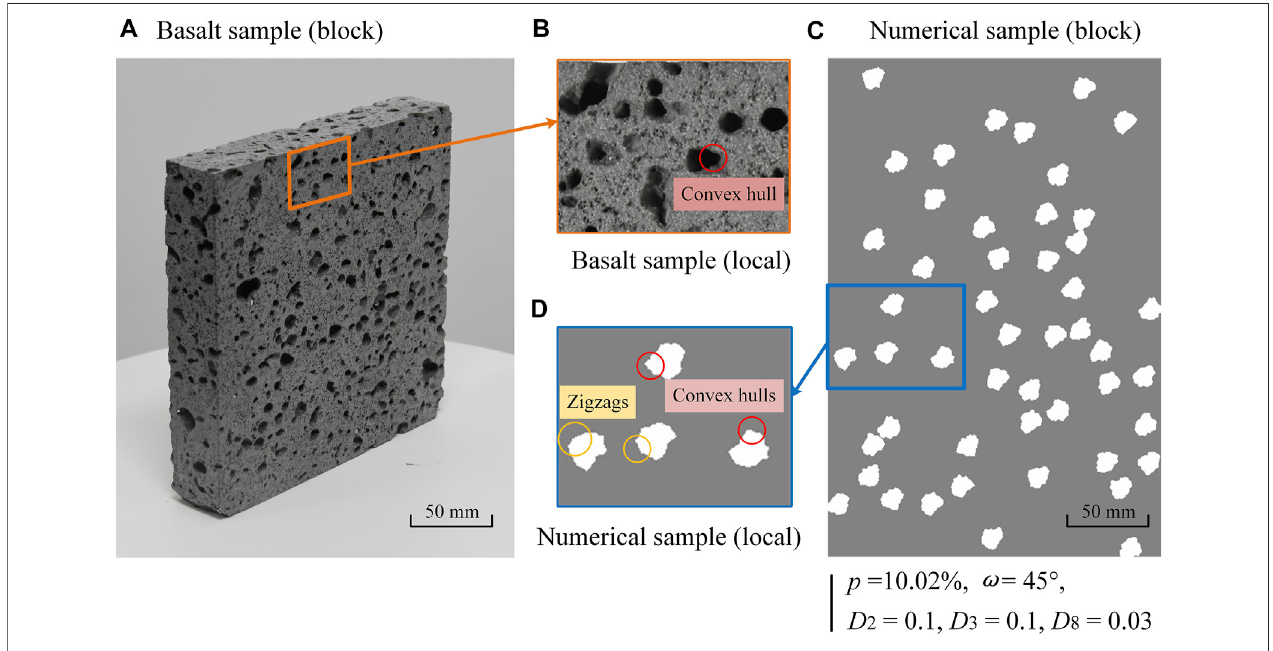
FIGURE 14 | Convex hulls and zigzags of pores in natural basalts and regenerated numerical porous sample: (A) basalt sample; (B) local basalt sample; (C) numerical sample with porosity of 10.02%, pore direction angle of 45 ° , and Fourier descriptors D 2 = 0.1, D 3 = 0.1, and D 8 = 0.03; and (D) local numerical samples.